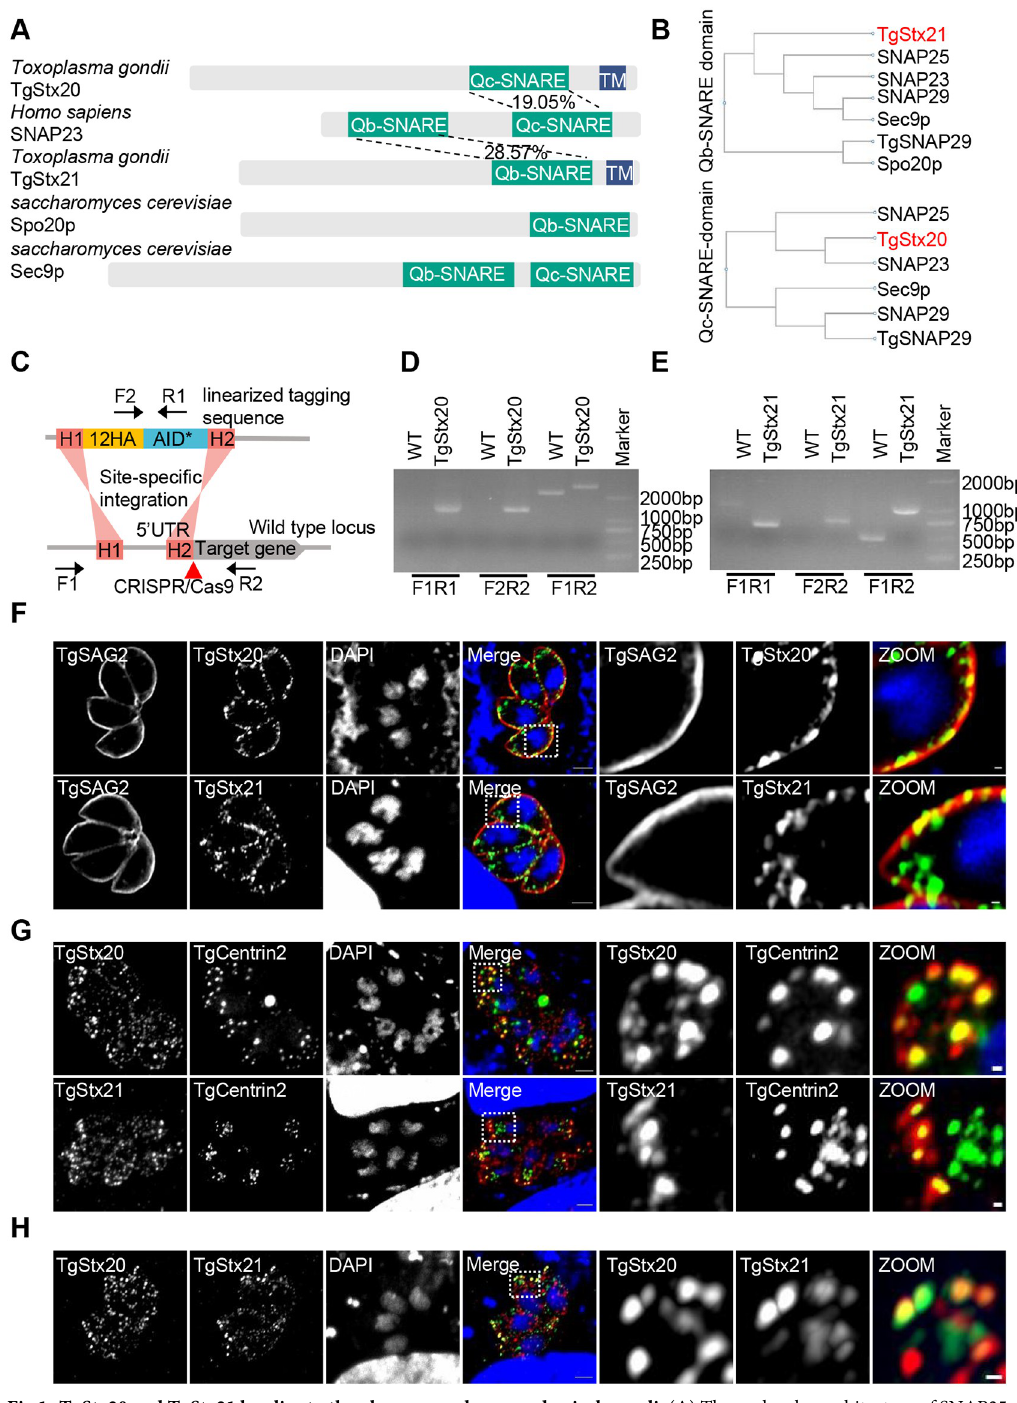
Fig 1. TgStx20 and TgStx21 localize to the plasma membrane and apical annuli. ( A ) The molecular architecture of SNAP25 family proteins. The percent identity values are shown. ( B ) Phylogenetic analysis of Apicomplexan, Saccharomyces cerevisiae , and human SNAP25 family proteins and homologs. ( C ) Schematic representation of the AID * -based system used to conditionally deplete the SNAREs. ( D ) and ( E ) PCR analysis of the integration of 12HA-AID * -TgStx20 (D) and 12HA-AID * - TgStx21 (E) at the genomic locus using the indicated primers. ( F ) IFA showing that 12HA-AID * -TgStx20 (green) and 12HA-AID * -TgStx21 (green) partially colocalized with the plasma membrane protein TgSAG2 (red). Scale bars: 2 μ m (left panels) and 0.2 μ m (zoomed panels). ( G ) IFA showing that TgStx20 (red) and TgStx21 (red) partially colocalized with the apical annuli protein TgCentrin2 (green). 12HA-AID * -TgStx20 or 12HA-AID * -TgStx21 parasites were transiently transfected with